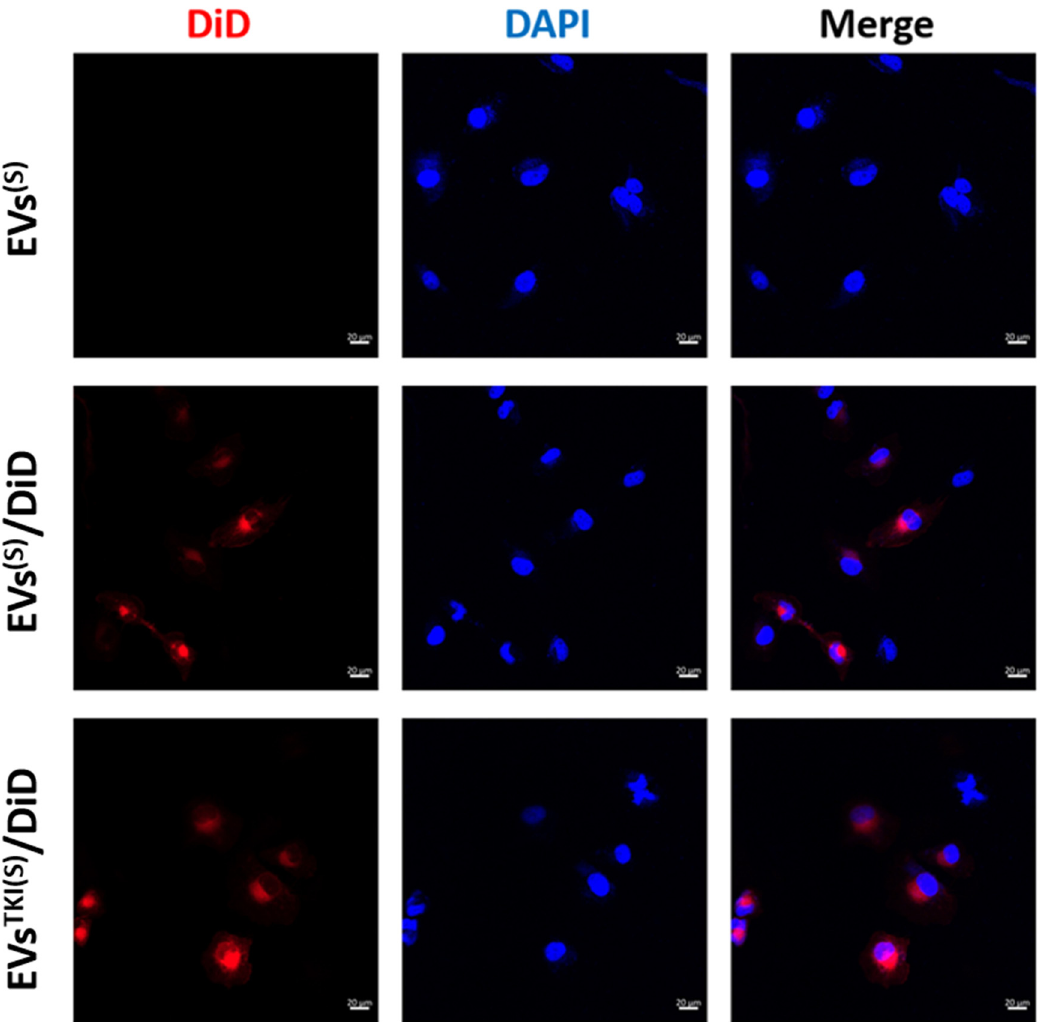
Figure 5. Internalization of the EVs into ATC cells. SW1736 ATC cells were incubated with EVs (S) , EVs (S) /DiD, or EVs TKI(S) /DiD (scale bar: 20 µm).